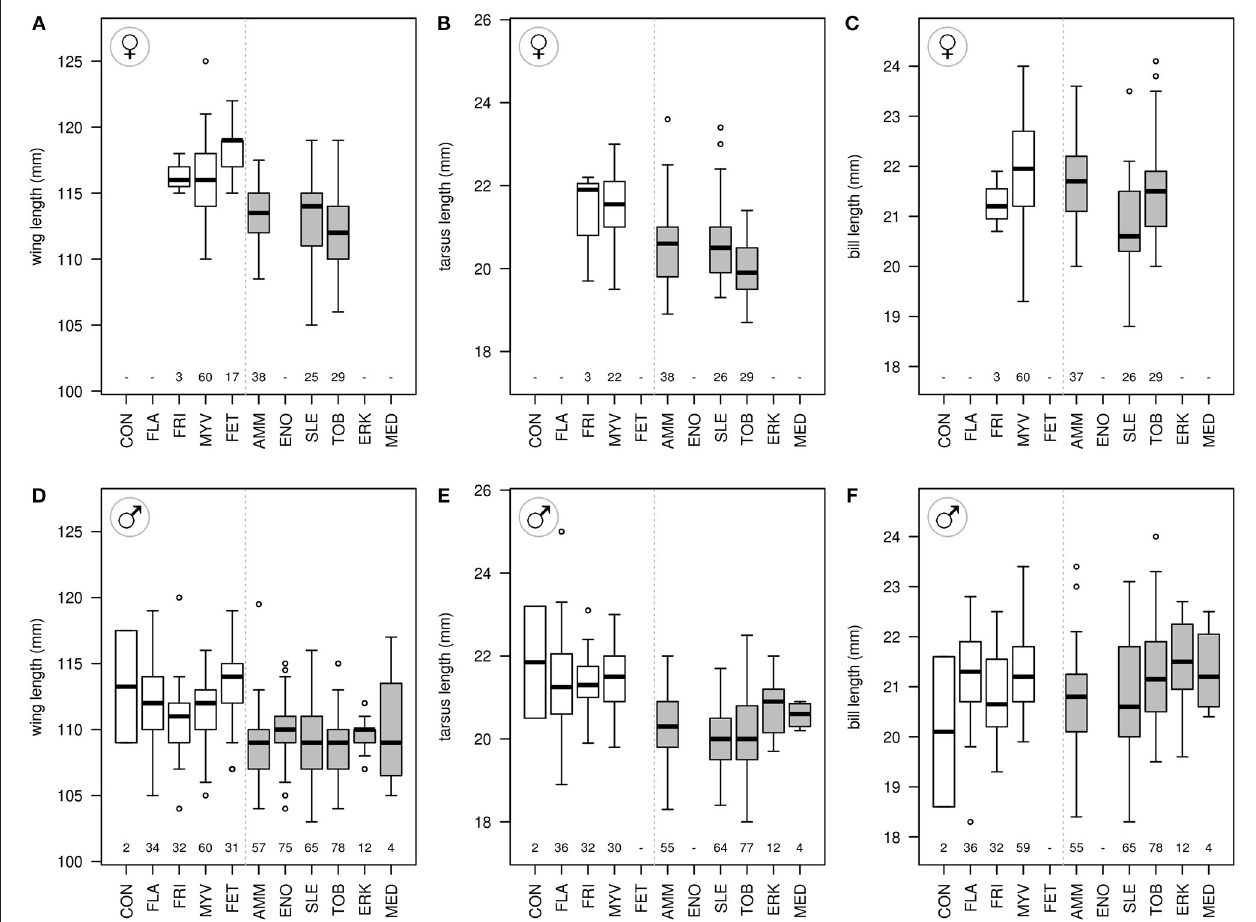
FIGURE 7 | Biometrics (wing, tarsus, and bill length) for female (A–C) and male (D–F) red-necked phalaropes for western (white boxes) and eastern (gray boxes) breeding sites. Boxes represent 50% of the values with the median as a horizontal line, and vertical bars extend to 95% quantiles. For abbreviations of sampling sites, see Figure 3 . Numbers below boxplots show sample